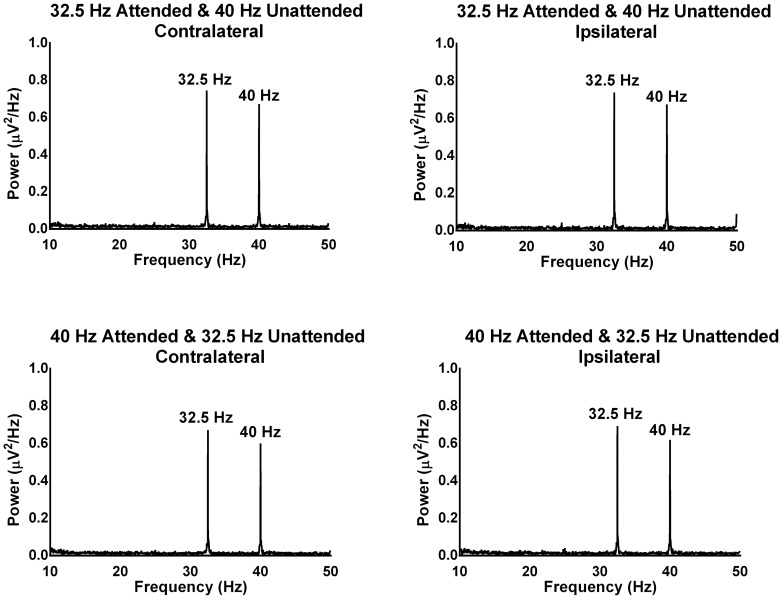
The grand mean FFTs for 32.5 and 40 Hz modulation frequencies during attended and unattended conditions across ipsilateral and contralateral activations combined from the two electrodes (T7 & T8).The power in the FFTs is an absolute value expressed in terms of squared microvolts per every 1 Hz of frequency (µV2/Hz).